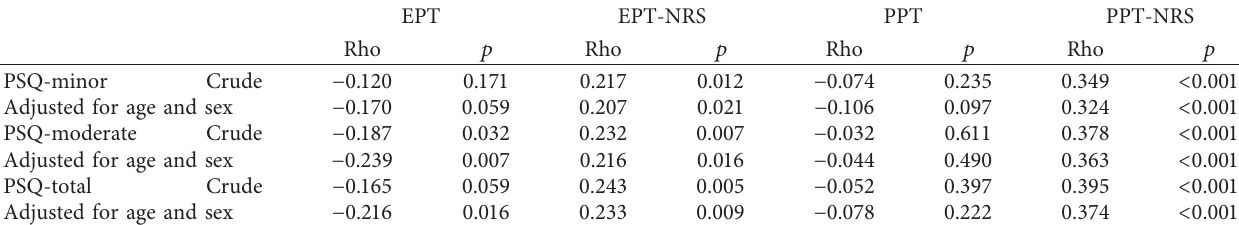
Table 3: Correlation between PSQ measures and QST measures ( n � 394: EPT n � 132; PTT n � 266).